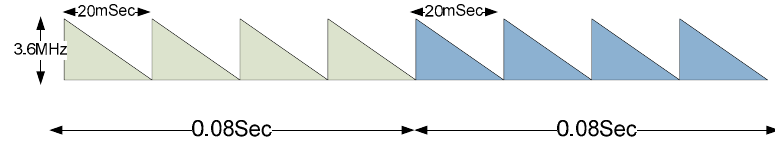
Figure 6. Four chirps pulse train.